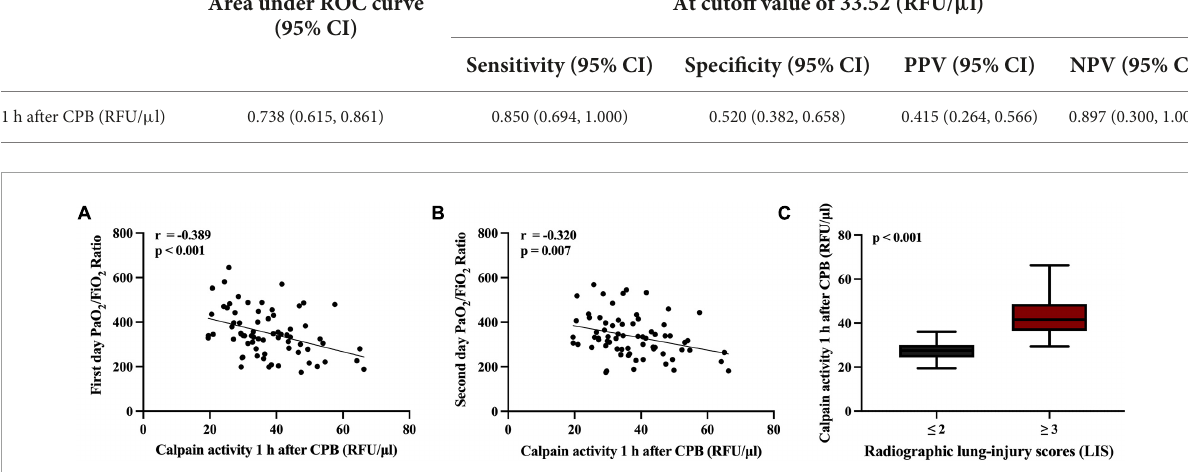
TABLE 4 Performance of serum level of calpains 1 h after cardiopulmonary bypass (CPB) (RFU/ µ l) for diagnosis of acute lung injury (ALI).